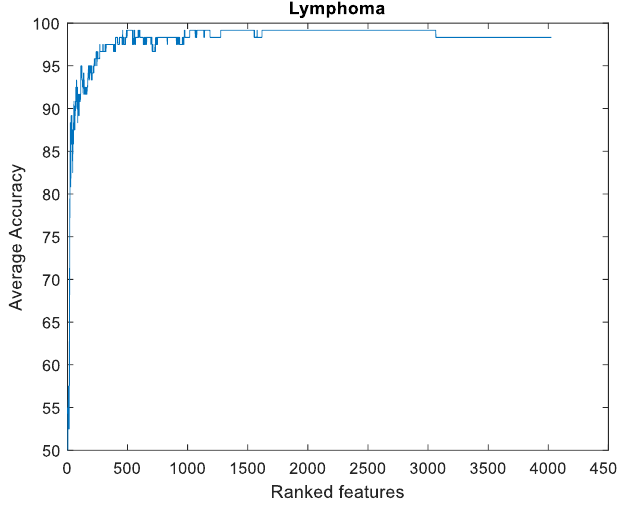
Fig. 5. The average accuracy of the ranked features for the lymphoma